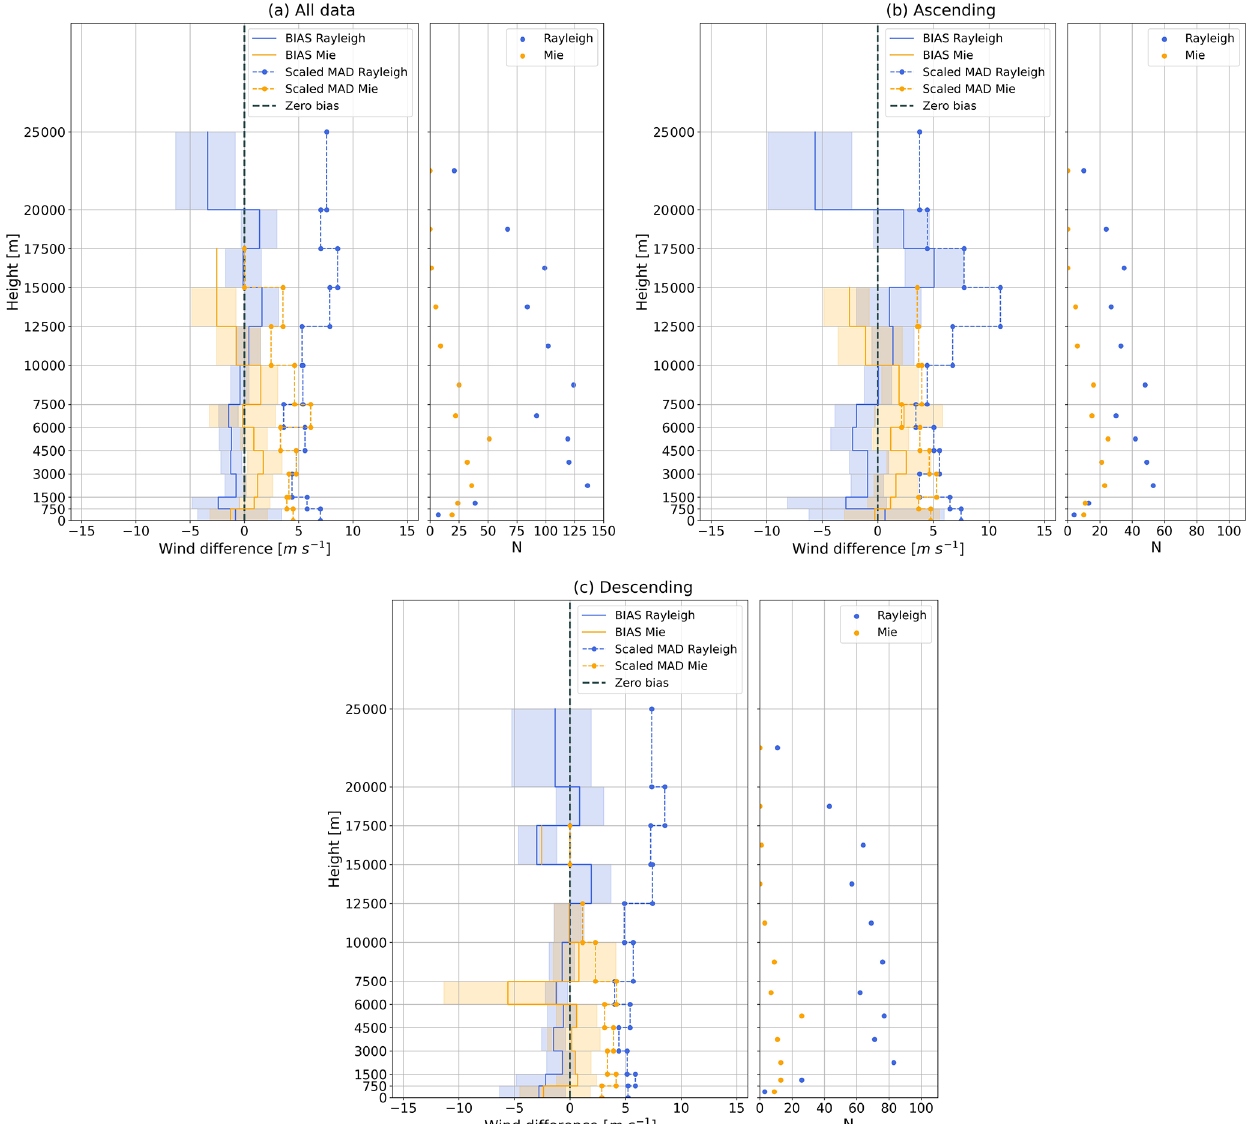
Figure 5. Wind differences (Aeolus-WPR) with height for (a) all data, (b) ascending orbits, and (c) descending orbits. Left: bias and scaled MAD of wind differences as a function of height, with shading areas representing the uncertainty. Right: the number of available match-ups at each height. Blue and orange colours indicate the results for the Rayleigh and Mie channels, respectively.